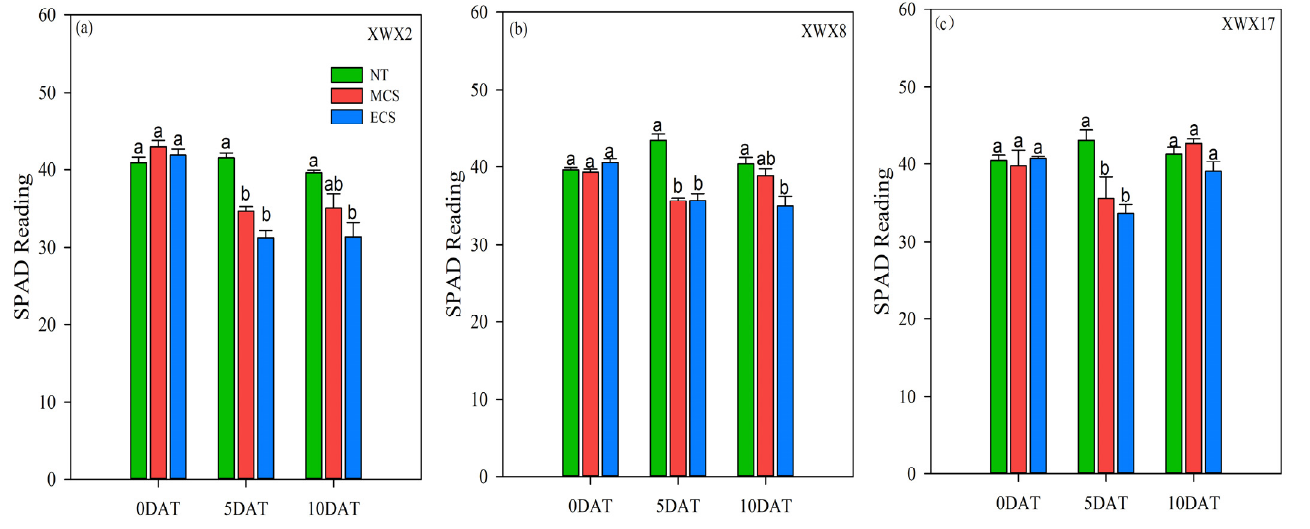
Figure 5. The flag leaf SPAD reading of three inbred late varieties under different temperature treatments. ( a ) XWX2. ( b ) XWX8. ( c ) XWX17. DAT: Days after temperature treatments; XWX2: Xiangwanxian2; XWX8: Xiangwanxian8; XWX17: Xiangwanxian17; NT: Normal temperature control; MCS: Moderate chilling stress; ECS: Extreme chilling stress. Different lowercase letters denote statistical differences among treatments of a cultivar at the 5% level according to LSD test. Error bars above mean indicate standard error ( n = 3).